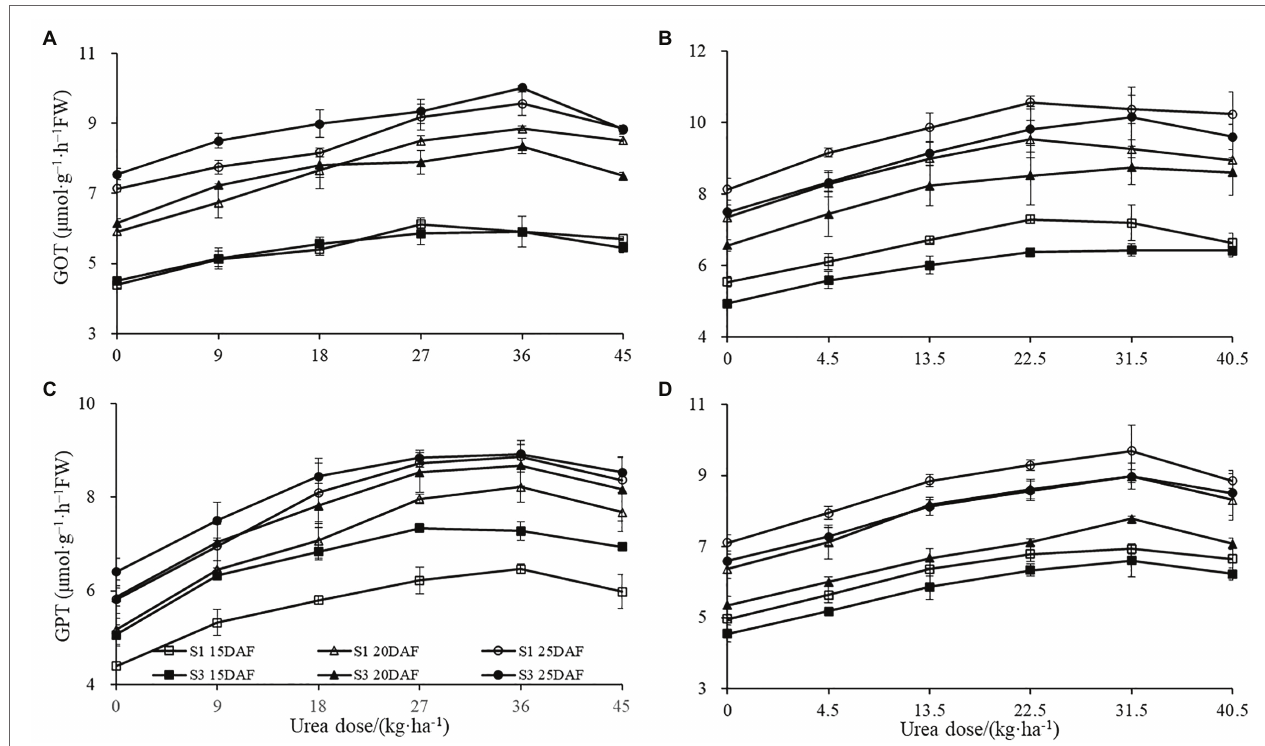
FIGURE 5 | The boll shell GOT and GPT activity under different urea doses in 2017 (A,C) and 2018 (B,D) . GOT represents the abbreviation of “glutamate oxaloacetate transaminase,” GPT represents the abbreviation of “glutamic-pyruvic transaminase,” FW represents the fresh weight of the sample, DAF represents the abbreviation of “days after flowering,” and S1 and S3 represent the Sikang 1 and Sikang 3,